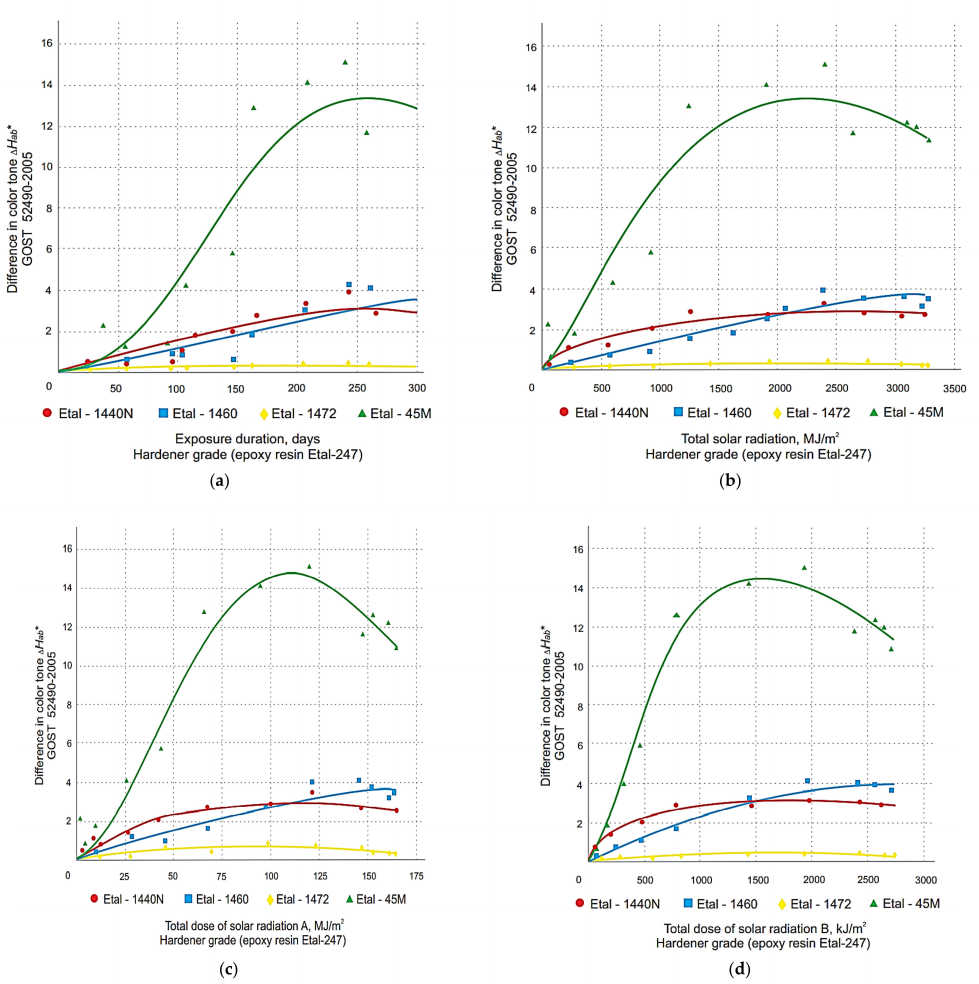
Figure 4. Change in the difference in the color tone of polymers based on the modified epoxy resin Etal-247 depending on the duration of exposure ( a ), total solar radiation ( b ), total ultraviolet radiation of the range A ( c ) and B ( d ) when exposed under the influence of climatic